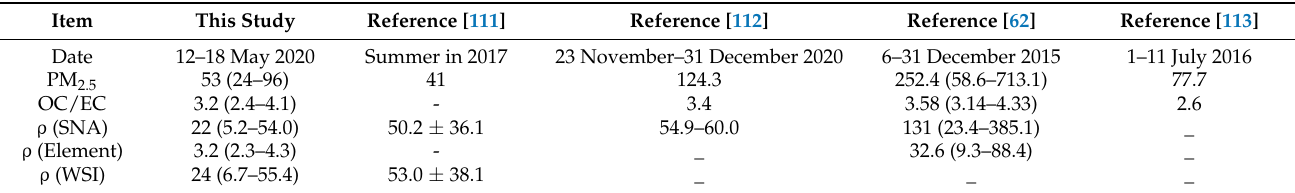
Table 3. Comparison with other studies on characteristics of PM 2.5 .